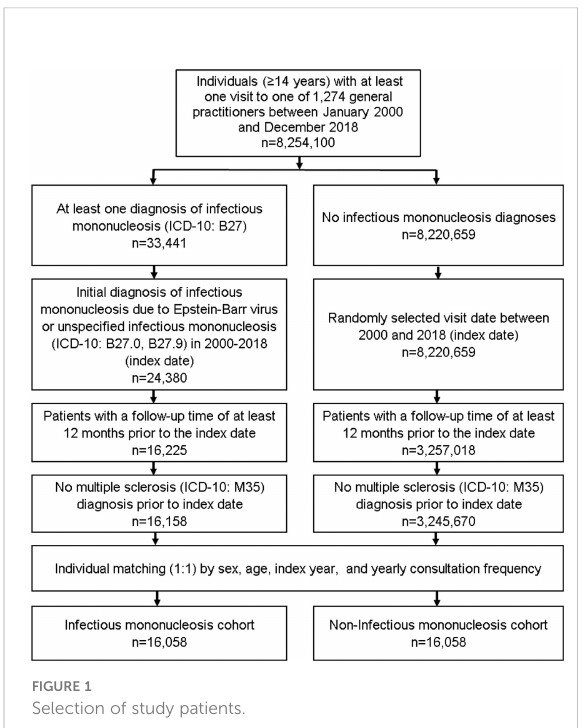
FIGURE 1 Selection of study